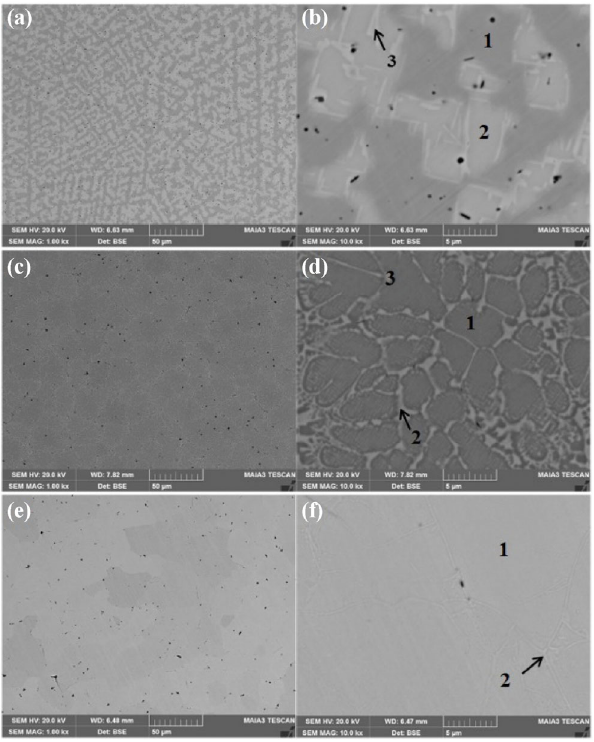
Fig. 3 SEM backscattered electron images of as-solidified CoCrFeNiTi 0.5 Al x alloys. (a, b) Low- and high-magnification images of CoCrFeNiTi 0.5 , respectively. (c, d) Low- and high-magnification images of CoCrFeNiTi 0.5 Al 0.5 , respectively. (e, f) Low- and high- magnification images of CoCrFeNiTi 0.5 Al, respectively.